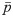
Equilibrium state of a population from diverse individual norms.The top (bottom) panels display the asymptotic values of four population variables describing the equilibrium state of the population as a function of Δ and the noise K (the learning error range ε): (a, b, e, f) fairness (i.e., p¯ and q¯), (c, g) empathy (i.e., e¯) and (d, h) collective conformity (i.e., c¯). All other model setups are the same as those used in Fig 1.